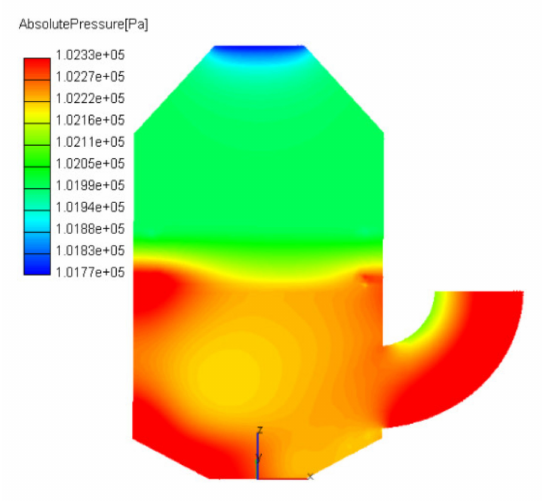
Figure 4. Pressure map inside the